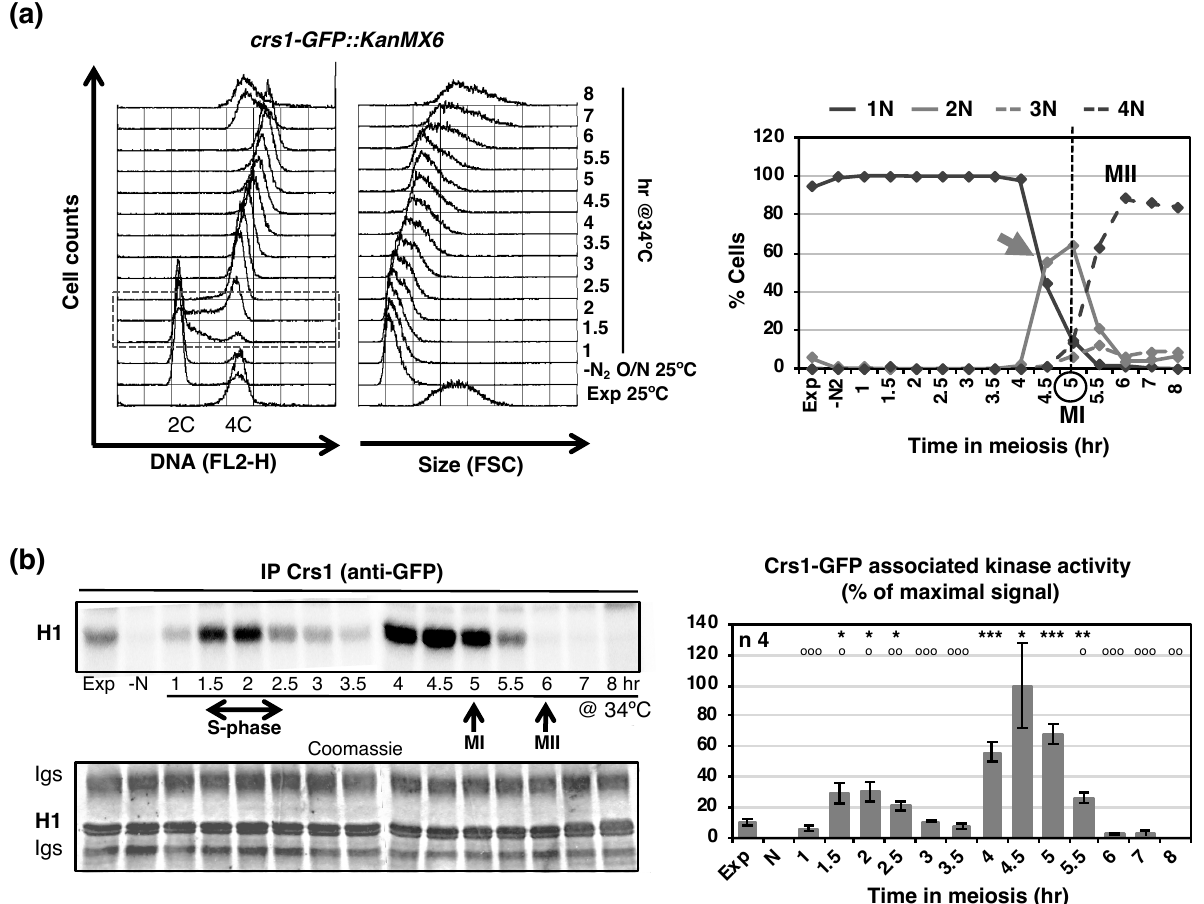
Figure 3. Crs1-GFP shows periodic associated kinase activity. ( a ) Flow cytometry analysis of synchronous meiosis of diploid pat1-114 crs1-GFP cells (CMC1000). DNA content (FL2-H) and Size (FSC) histograms are shown. Dashed-lined box outlines S-phase progression. On the right: Quantification of chromosome segregation by DAPI staining and nuclear counting (1 nucleus, 2 nuclei, 3 nuclei, and 4 nuclei) is shown. The arrow indicates meiosis I (MI) entry, and the vertical dashed-line indicates the peak of MI. ( b ) Crs1-GFP associated kinase activity during synchronous diploid pat1-114 meiosis shown in ( a ). The top panel shows phosphorimager scanning of the assays ran in acrylamide gels. The bottom panel shows Coomassie staining of the same gels. Graph on the right represents kinase activity as the mean of the percentage relative to the maximal signal +/ − SEM of 4 independent experiments. Time points during the meiotic time course (from 1 h to 8 hr) were compared to 1 h (*) and 4 h signal ( o ). * comparison shows the statistical definition of the two peaks of activity at S-phase and meiosis I entry. o comparison shows the statistical difference between S-phase and meiosis I peaks. p value * and o < 0.05, ** and oo ≤ 0.01, *** and ooo ≤ 0.001 (Student ´ s t -test, unpaired, two tails). Only statistical differences are